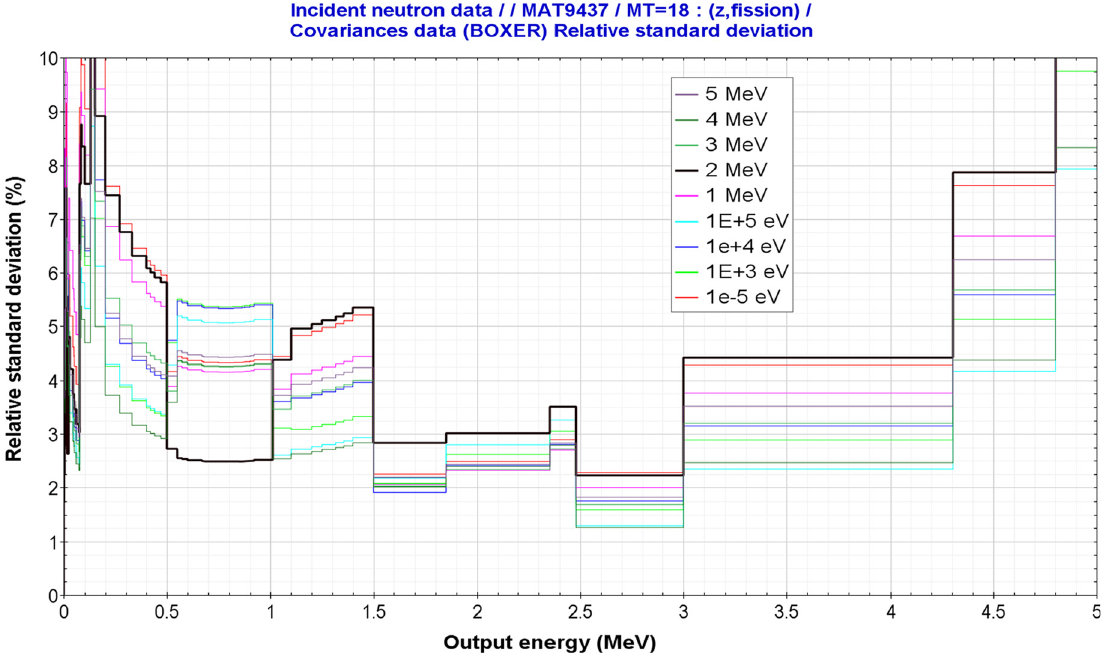
Fig. 5. Relative standard deviation of 239 Pu PFNS in TENDL-2014 for different NJOY Ef mean input Table 5. PFNS k uncertainties from different Ef mean eff values, default Ef mean = 2 MeV.